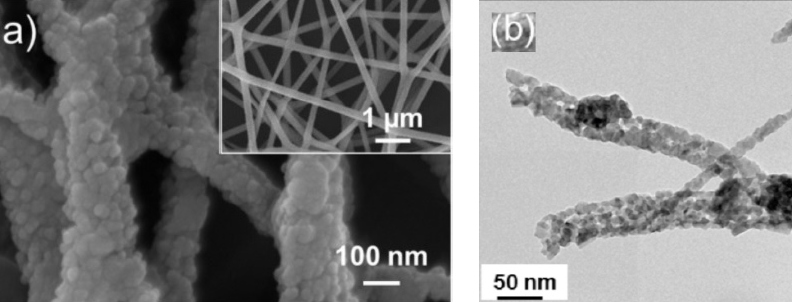
Figure 1. ( a ) FE-SEM image of ZnO electrospun NFs. The inset indicates high magnification image [20] ( b ) TEM image of 0.5 SnO 2 –0.5 Co 3 O 4 composite NFs [21].